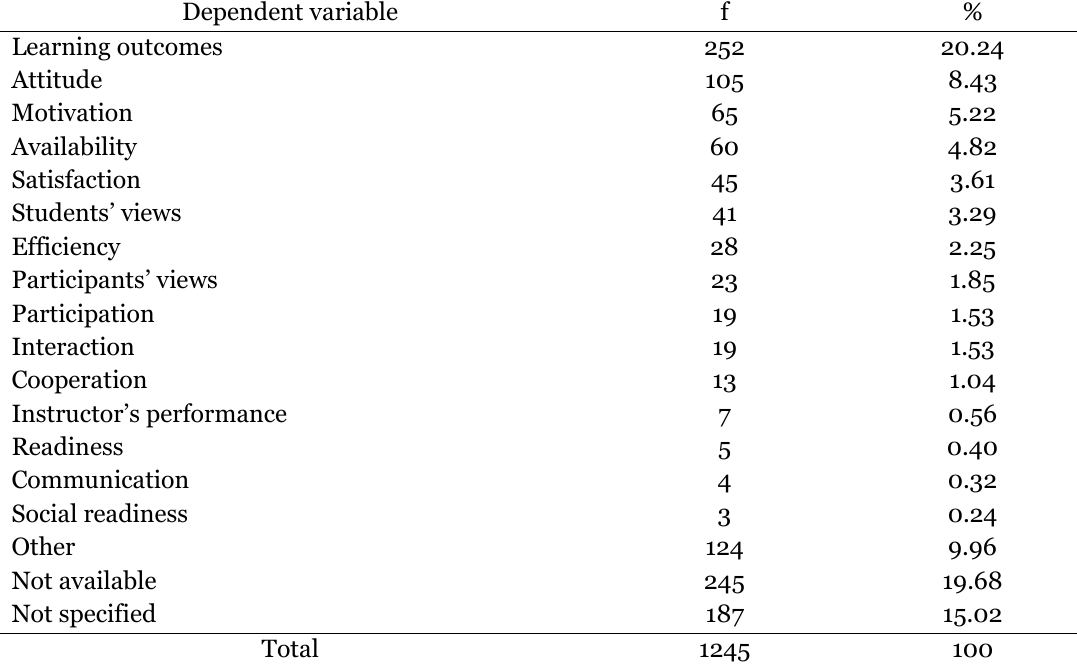
Distribution of Studies According to Dependent Variable Dependent